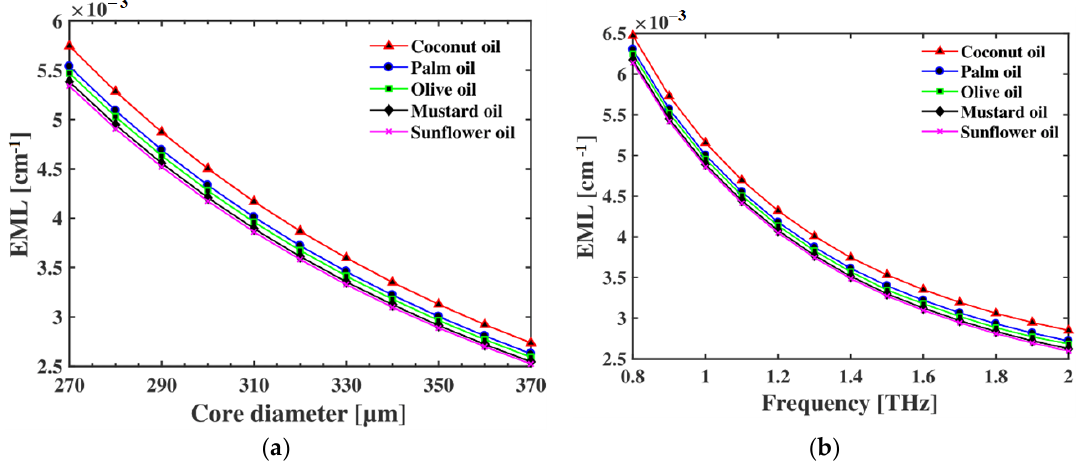
Figure 4. Effective material loss (EML) characteristics of the proposed oil detector for ( a ) different core diameters at an operating frequency of 1.6 THz and ( b ) different values of frequencies at 340 µm core diameter.